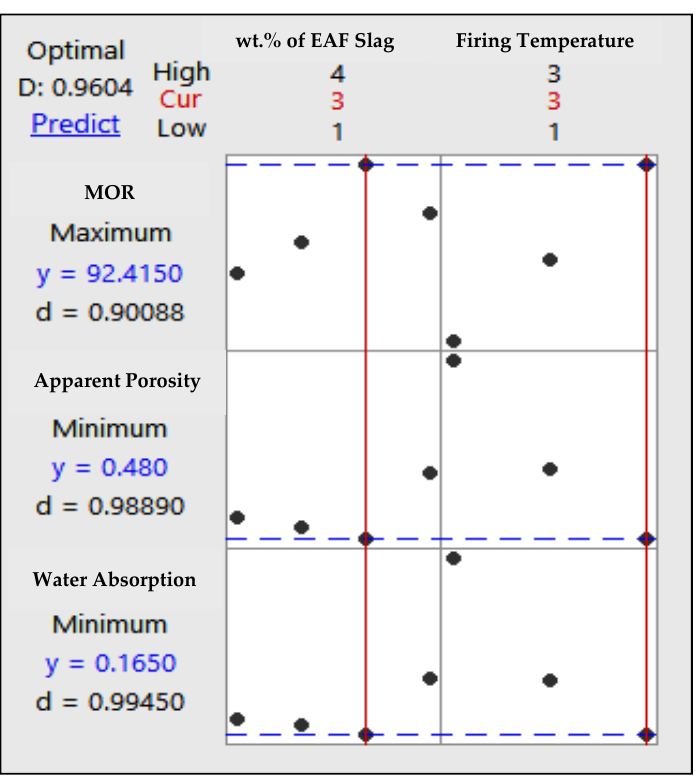
Figure 5. Optimal conditions of controlled factors (wt.% of EAF slag and firing temperature) on selected responses of ceramic tile incorporated with EAF slag.